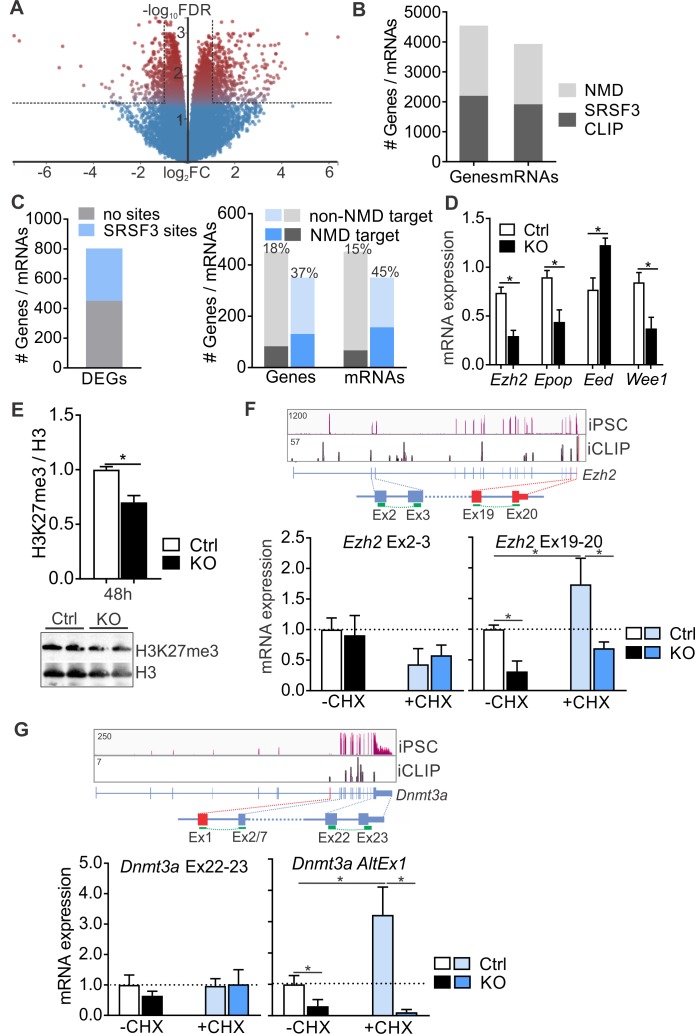
SRSF3 mediates the abundance of distinct mRNAs encoding chromatin modifiers to facilitate pluripotency.(A) Volcano plot depicting differentially expressed genes following SRSF3 depletion in pluripotent cells. The dotted lines illustrate fold change (FC) >2 and FDR < 0.05. (B) Number of genes and mRNAs regulated at the level of NMD based on Hurt et al. (2013) and the fraction of them with significant SRSF3 crosslink sites. (C) Left: Differentially expressed genes (DEGs) following SRSF3 depletion with and without SRSF3-binding sites. Right: The fraction of differentially expressed genes/mRNAs with (blue bars) and without (grey bars) SRSF3-binding sites that were regulated at the level of NMD. The percent value above the bars denotes the fraction of NMD regulated genes or mRNAs (dark blue or grey) in each category. (D) RT-qPCR quantification of PRC2 components in Srsf3-KO (KO) and control (Ctrl) iPSCs 24 hr after 4OHT induction. The data is normalised to Hprt and presented relative to control iPSCs (*p<0.05, Unpaired Student’s t-test, two-tailed, data as mean ± SEM, n = 3–9). (E) Western blot analysis of H3K27me3 and total H3 levels 48 hr after 4OHT induction in Srsf3-KO (KO) and control (Ctrl) iPSCs. Quantification presented as H3K27me3 relative to total H3 (*p<0.05, Unpaired Student’s t-test, two-tailed, data as mean ± SEM, n = 2). (F) Top: Ezh2 expression in iPSCs and SRSF3 iCLIP binding profiles within the transcript region. Primers binding to the exons in red were used to measure the NMD-regulated transcript variant. Below: RT-qPCR quantification of total Ezh2 (Ex2-3) and full-length transcript variant (Ex19-20) in control (Ctrl) and Srsf3-KO (KO) iPSCs before (-CHX) and after (+CHX) NMD inhibition. The data is normalised to Hprt and presented relative to control iPSCs (*p<0.05, One-way ANOVA, data as mean ± SEM, n = 3). (G) Top: Dnmt3a expression in iPSCs and SRSF3 iCLIP binding profiles within the transcript region. Primers detecting the alternative first exon (red) were used to measure the NMD-regulated transcript variant. Below: RT-qPCR quantification of total Dnmt3a (Ex22-23) and Dnmt3a alternative exon 1 (AltEx1) containing transcripts as in (F). See also Figure 7—source data 1.10.7554/eLife.37419.025Figure 7—source data 1.Differentially expressed genes following SRSF3 depletion.